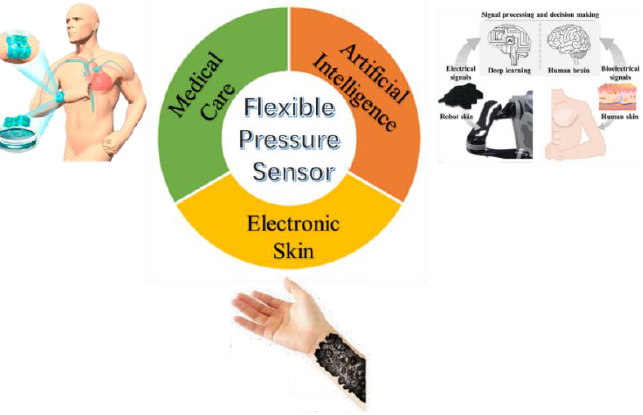
Figure 1. Wide application fields of flexible pressure sensors [8,16,20].